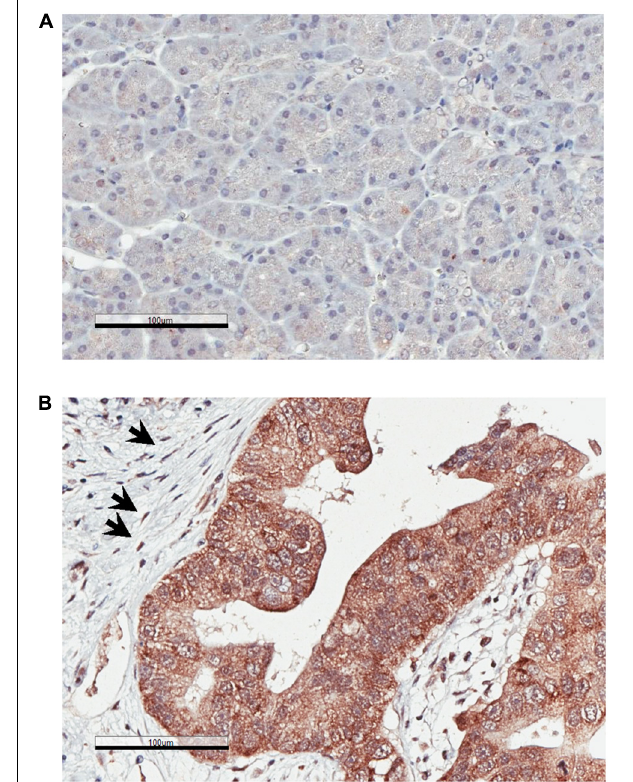
FIGURE 3 | Recepteur d’Origine Nantais (RON) expression is increased in PDAC. IHC analysis of human pancreatic specimens using anti-RON antibody. (A) Normal pancreas; (B) PDAC. The arrows indicate RON-positive stellate cells. Magnification: 20 × ; Scale bar: 100 µ m.